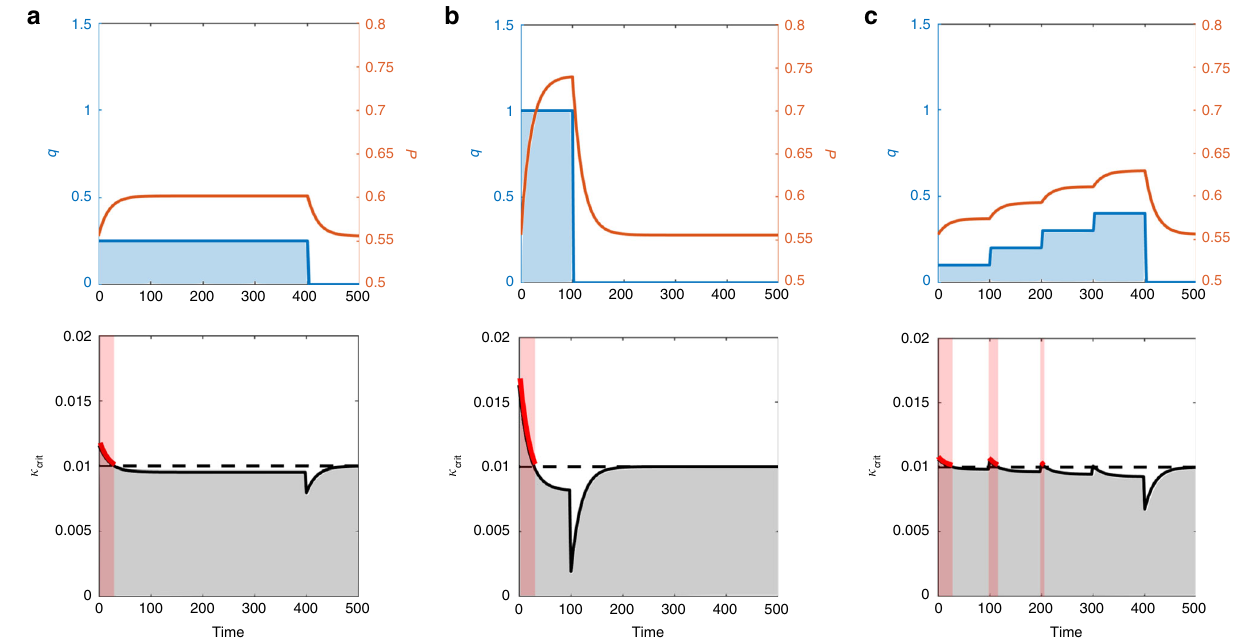
Fig. 3 Comparison of stability pro fi les for three different injection scenarios with the same total injected volume. a reference injection rate and period of injection ( c = 3 × 10 − 2 , rq = 5 × 10 − 3 ); b fourfold increase in injection rate, and corresponding fourfold decrease in the period of injection ( c = 3 × 10 − 2 , rq = 2 × 10 − 2 ); c linear ramp-up in injection rate over the same period of injection as the reference case ( c = 3 × 10 − 2 , rq = 2 × 10 − 3 ). The top fi gures show injection rates (blue) and pore pressures (orange). The bottom fi gures show the critical stiffness in response to the different injection scenarios (solid black) compared to the pre-injection critical stiffness value (dashed black). Higher peak in critical stiffness is indicative of higher likelihood for triggering